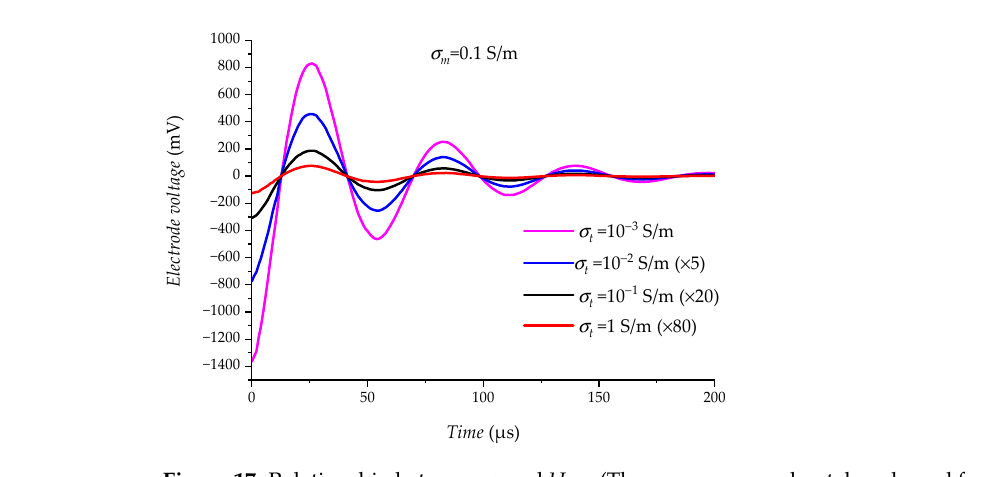
U . (The curves are moderately enlarged for ease of dis- and t Ex